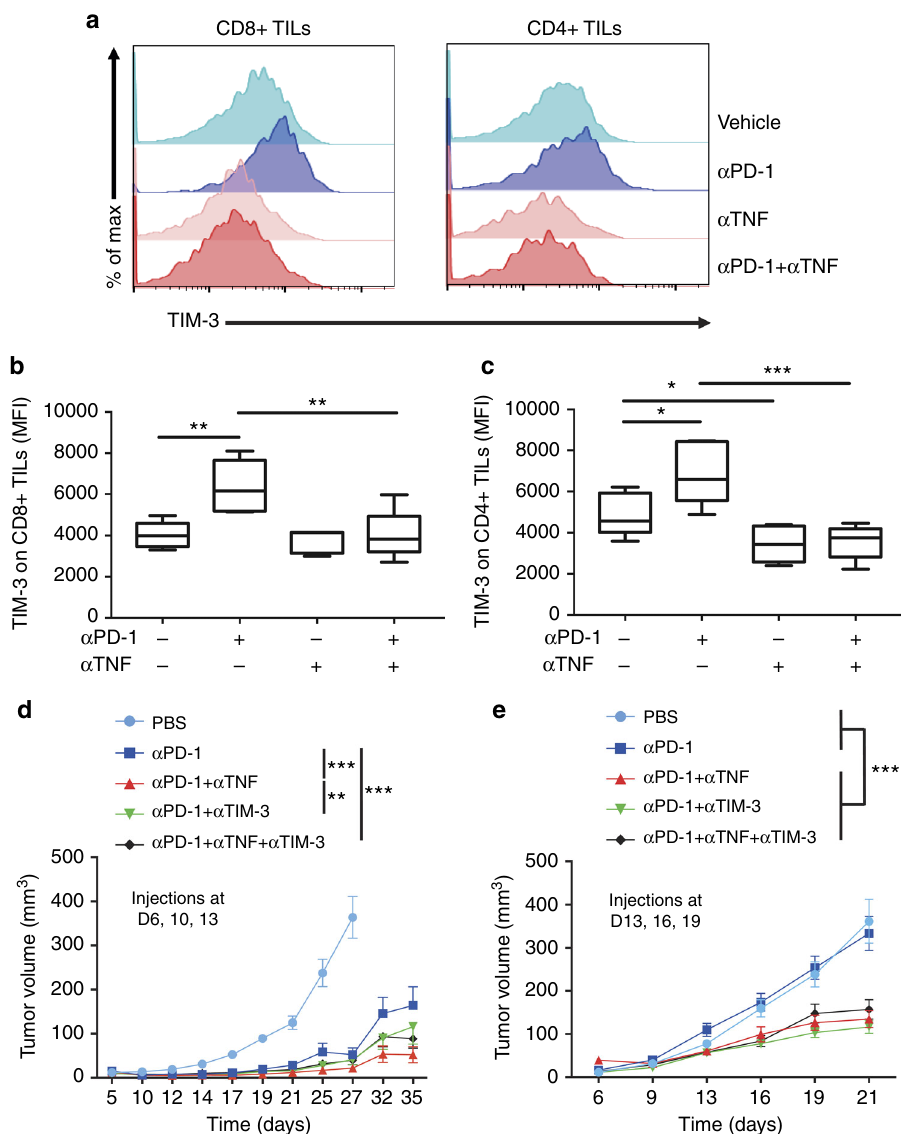
Fig. 6 TNF blockade prevents TIM-3 up-regulation on TILs in response to anti-PD-1. WT mice were injected as described in the legend to Fig. 5. a – c TIM-3 expression level on CD8+ TILs and CD4+ TILs was determined by fl ow cytometry on tumors from WT mice at day 10 after B16K1 graft following injection of vehicle (PBS), anti-PD-1 ( α PD-1), anti-TNF ( α TNF) or a combination of both. Representative stainings ( a ) mean fl uorescence intensity (MFI) of TIM-3 on CD8+ ( b ) and CD4+ TILs ( c ) measured in at least 5 tumors per group from one experiment are represented as Tukey boxes. b , c : Mann – Whitney U test: * p < 0.05; ** p < 0.01; *** p < 0.001). d and e C57BL/6 WT mice were intradermally and bilaterally grafted with 3 × 10 5 B16K1 melanoma cells prior to injection with vehicle, anti-PD-1 alone or combined with anti-TNF and/or anti-TIM-3 (10 mg kg − 1 of each antibody) at days 6, 10, and 13 (d) (PBS ( n = 12), α PD-1 ( n = 9), α PD-1 + α TNF ( n = 14), α PD-1 + α TIM-3 ( n = 13), α PD-1 + α TNF + α TIM-3 ( n = 15), data from two experiments) or at days 13, 16, and 19 ( e ) ( n = 10 mice per group, data from one representative experiment out of two). Tumor volumes were determined with a calliper. Data are means ± s.e.m. (d) and e, two-way Anova: ** p < 0.01, *** p < 0.001 at day 35 ( d ) and day 21 ( e ); p = 0.08 at day 35 when comparing anti-PD-1 alone and anti-PD-1 plus